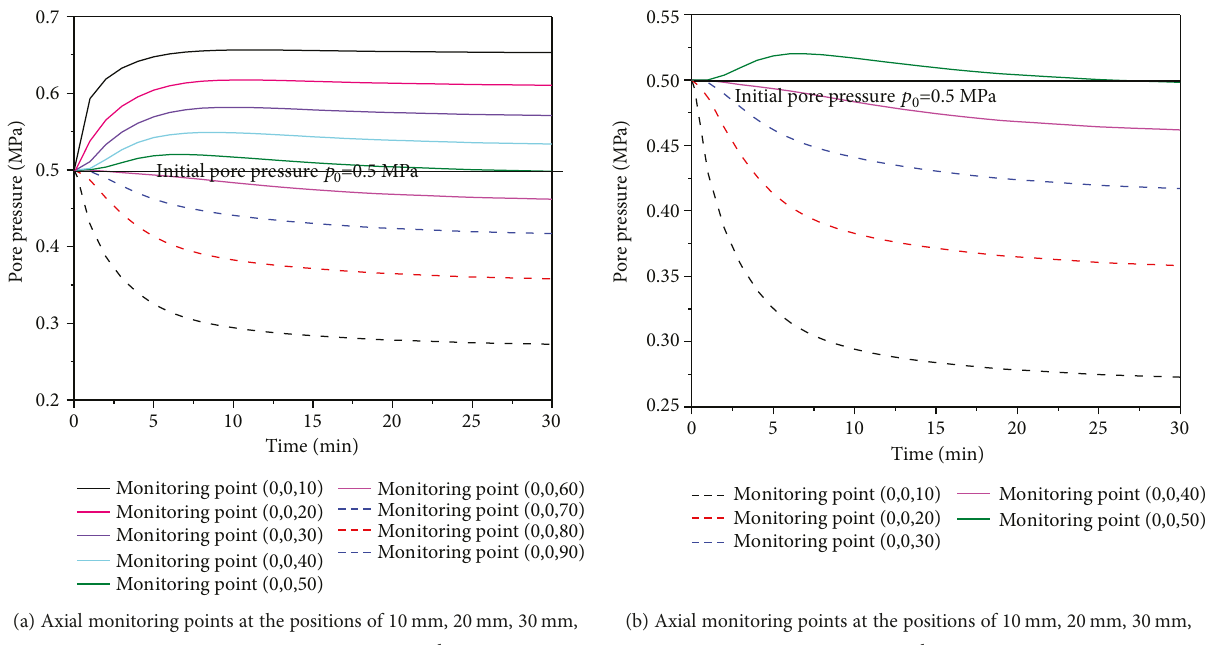
Figure 12: Space-time distribution curves of the pore pressure at the axial monitoring points along the driving direction.